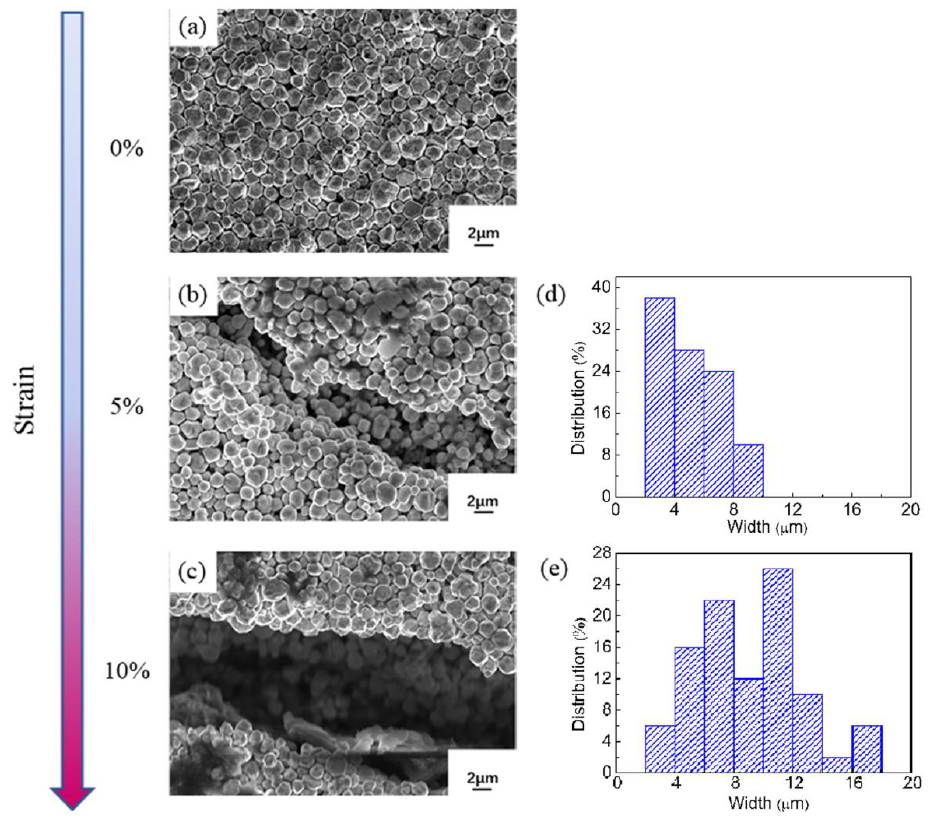
Figure 7. SEM images of microcracks under different strains: ( a ) 0% strain, ( b ) 5% strain, ( c ) 10% strain. The width distributions of microcracks under different strains: ( d ) 5% strain, ( e ) 10% strain.